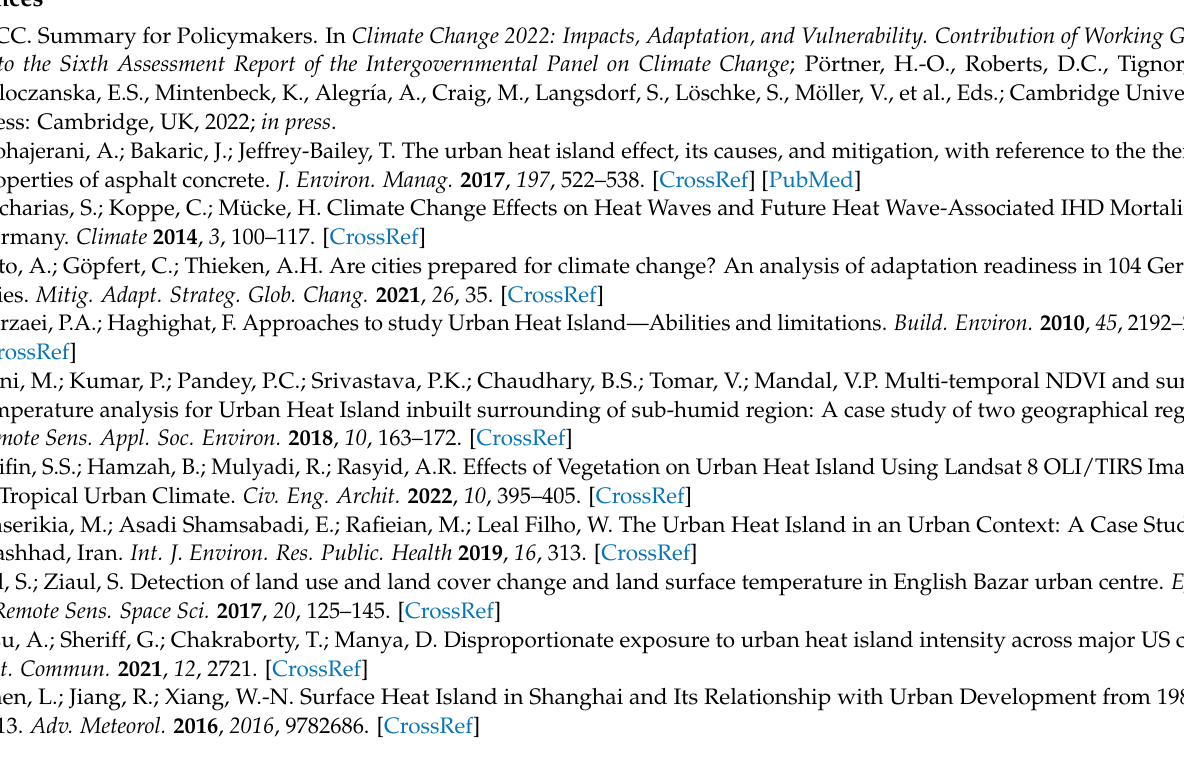
Figure A2. Correlation between the 2 metre air temperature (T Air ) from stations of the German weather service (DWD) in the administrative boundaries of Stuttgart [46] and land surface temperature (LST) from L5 and L8 averaged within a 60 m radius around each station. The dots show the LST data for every weather station in every Landsat tile used in this study and the corresponding 2 metre air temperature recorded the same day at 9 a.m. from the weather stations.